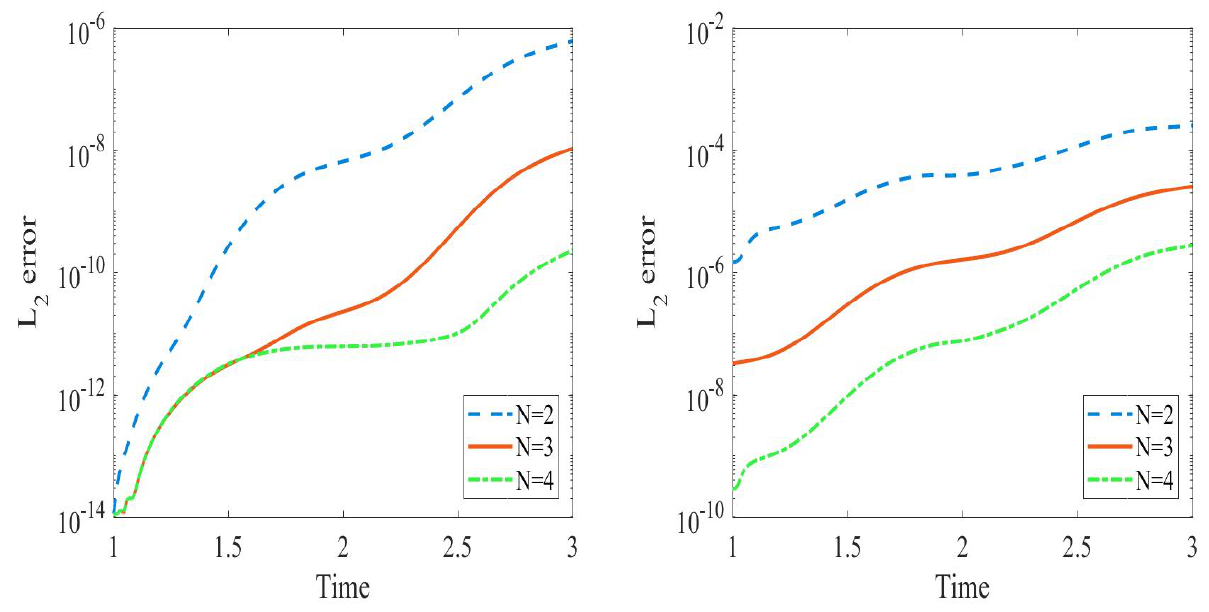
( left ) and contour lines ( right ) for the inviscid Burgers’ equation , switching at with number of modes  (  ,  )   =    =